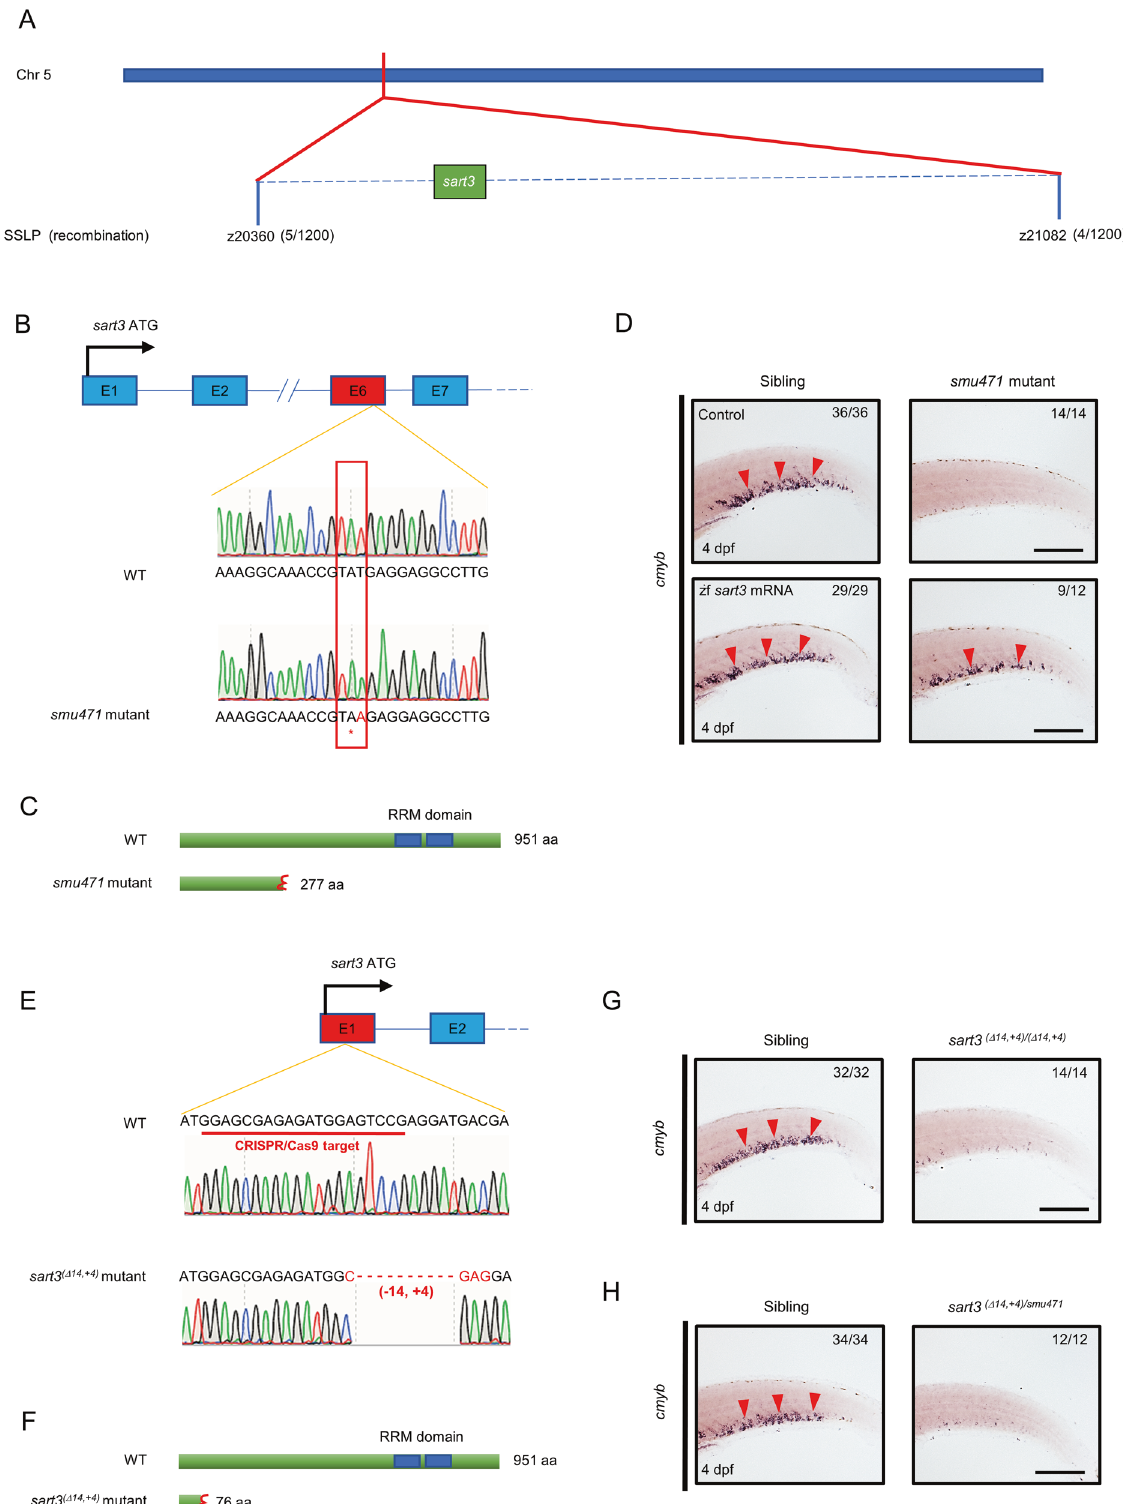
Fig. 2 sart3 is the causative gene of the zebra fi sh smu471 mutation. A Genetic map of the candidate region on chromosome 5 (Chr 5) located between two SSLP markers, z20360 (5 recombinants in 1200 smu471 mutants) and z21082 (4 recombinants in 1200 smu471 mutants). There are twenty candidate genes in this mapped region. B , C Sequencing of the candidate gene cDNAs showed a transition of T to A at sart3 exon 6, which predicted a stop codon ( B ) and truncated Sart3 protein ( C ). D Rescue assay. Zebra fi sh sart3 mRNA (zf sart3 mRNA) overexpression restored defective cmyb expression in smu471 mutants. E A 14-bp deletion and 4-bp addition in sart3 exon 1 were identi fi ed in CRISPR/Cas9 generated mutants. Sequence underlined in red indicates the CRISPR/Cas9 target in sart3 . F Premature Sart3 protein generated by the sart3 ( Δ 14, + 4) mutant. G cmyb + signals decreased in 4 dpf sart3 ( Δ 14, + 4) mutants. H cmyb + signals decreased in the 4 dpf bi-allelic sart3 ( Δ 14, + 4) / smu471 mutants. The red arrowheads indicate the cmyb signals. Scale bars: 200